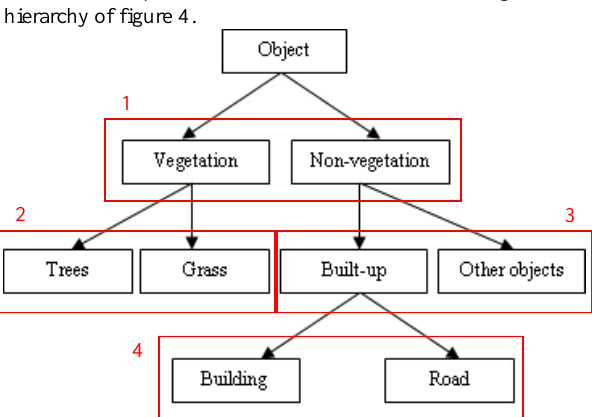
Figure 4. Hierarchy used for the classification of different objects